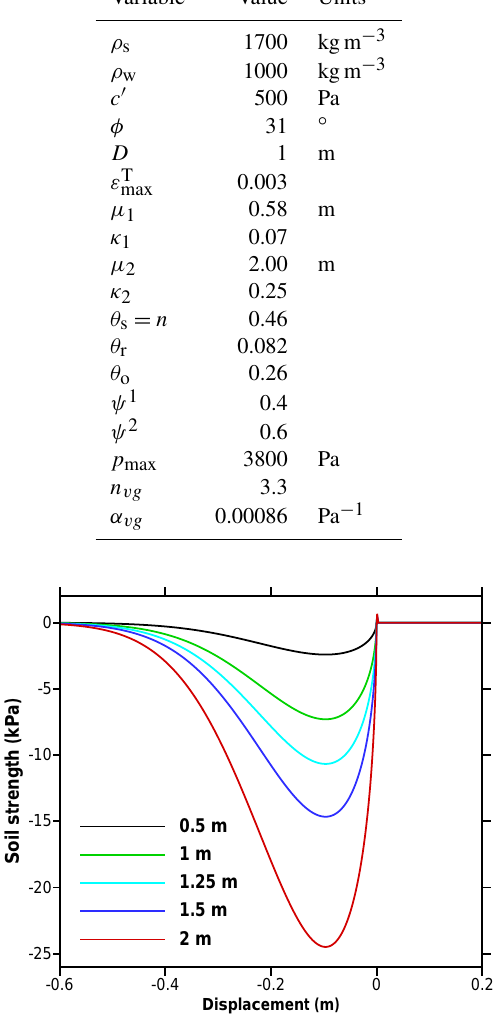
Figure 3. Soil strength as a function of displacement for different soil depths. Values of passive earth pressure coefficients for esti- mating soil compressional strength are calculated using a surface slope of 40 ◦ . Other parameters needed for the calculation are given in Table 2. Negative values of displacement indicate compression.